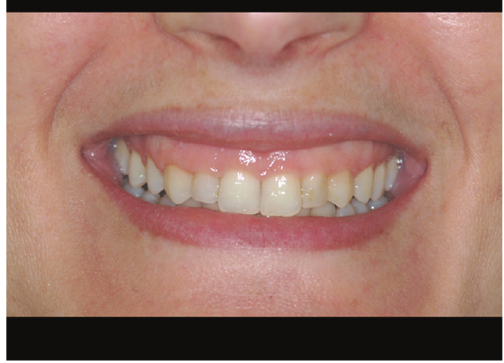
Figure 11: Pretreatment view of patient n.9.